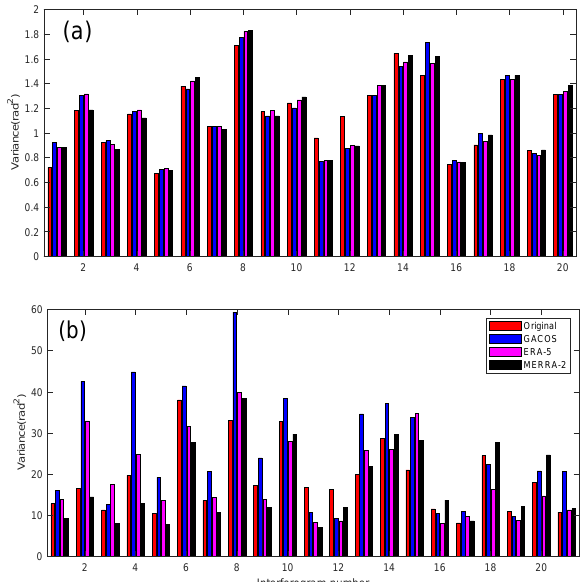
Figure 8. A comparison of the variances of the first 20 interferograms in the SBAS network in Appendix 1 before and after applying the correction using the NWM-based tropospheric delays . (a) shows the variances at lag distance 2000 m, while (b) shows the variance at lag distance 40000 m. Table 2. Summary of changes in the variances of corrected interferograms at a distance lag of 40000m